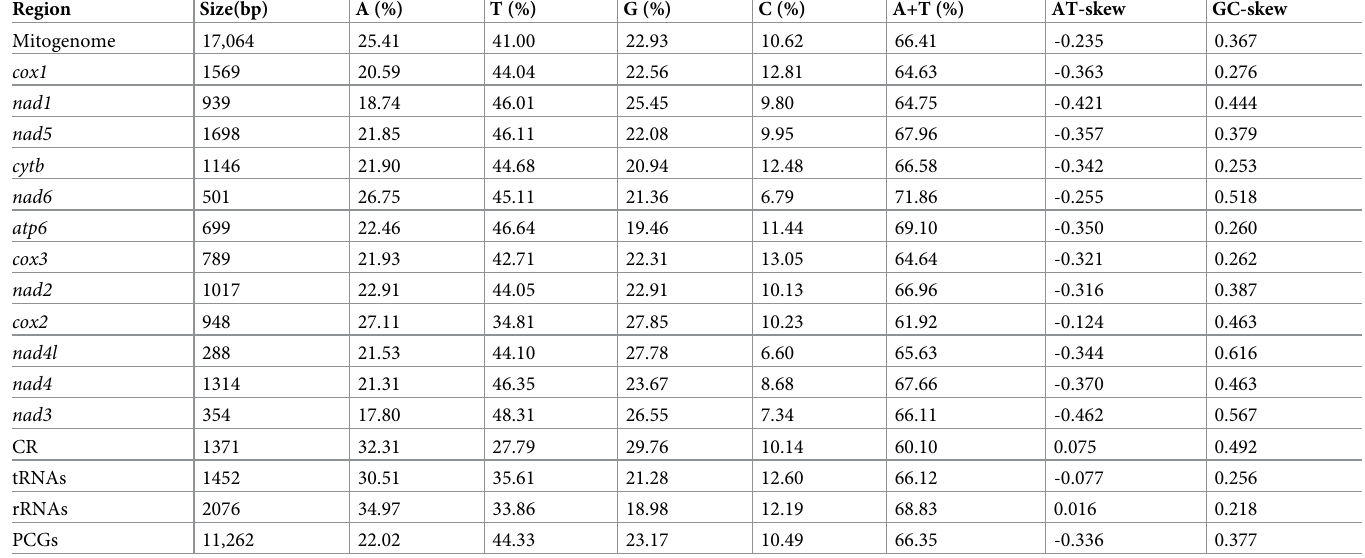
Table 2. Skewness of the S . minima mitogenome.